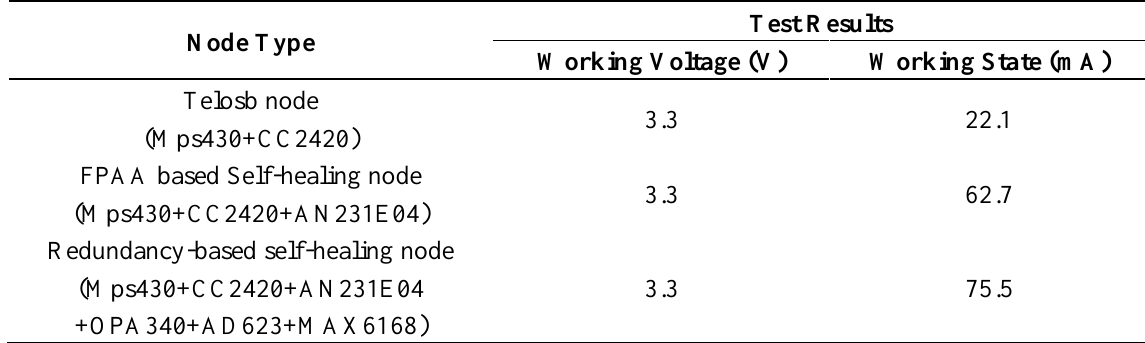
Table 4. Power consumption test